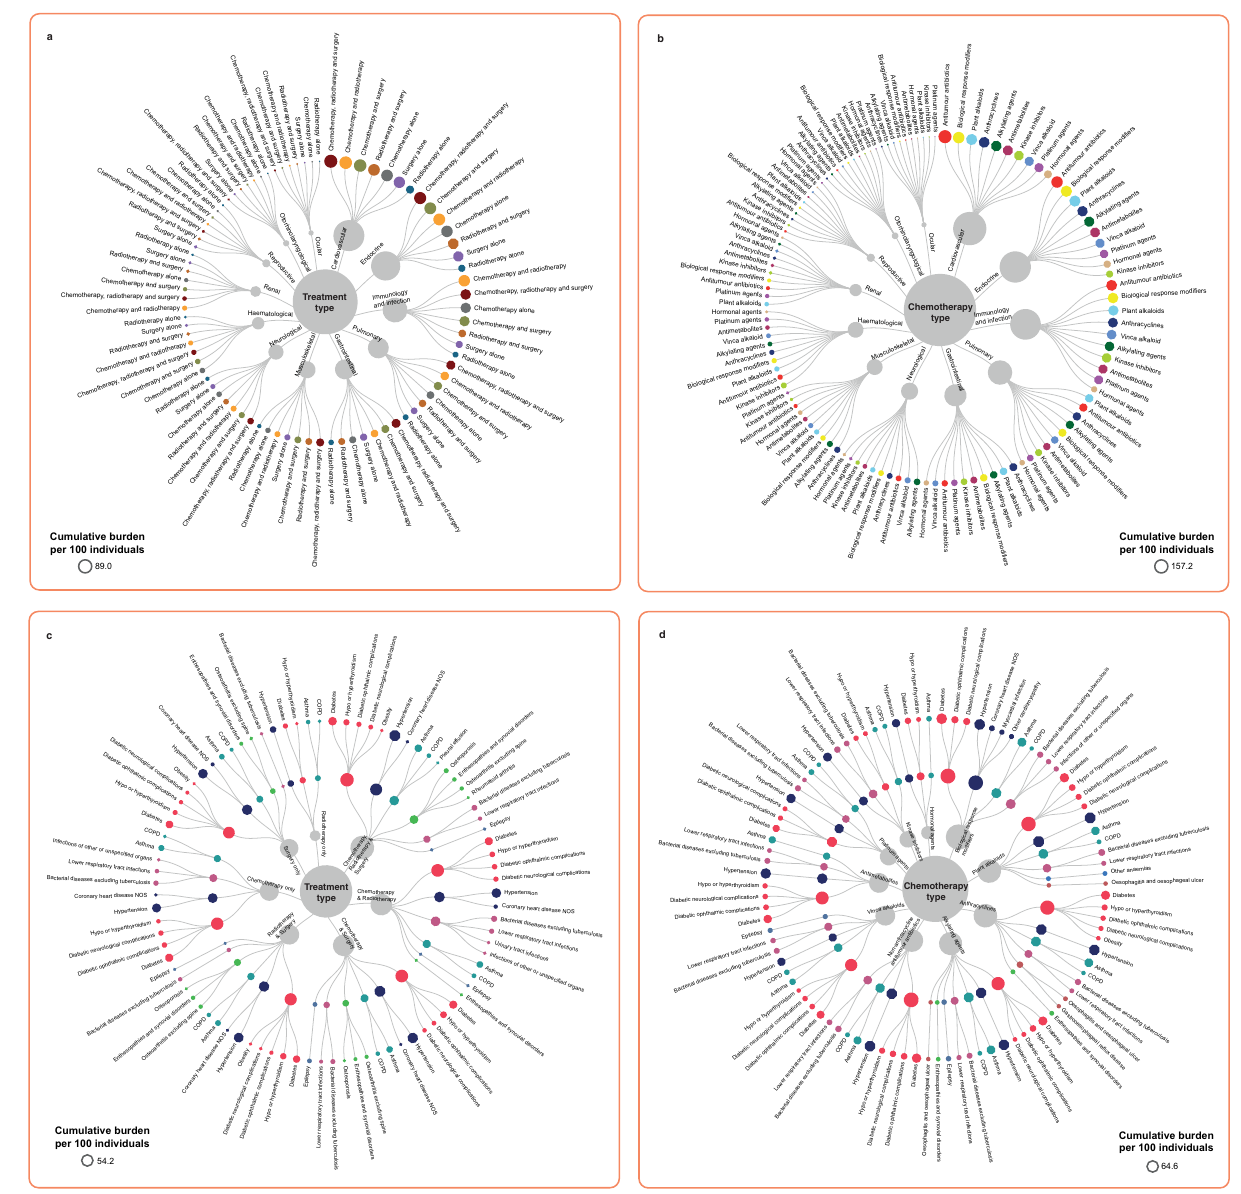
Fig. 4 |Cumulativeburdenofhealth conditionsamongcancer survivorsatage 60 by treatment type and chemotherapy agents. Cumulative burden per 100 individuals is shown. Dendrograms depict the cumulative burden of conditions where the top hierarchy is organ system followed by a treatment type or b chemotherapy type. This allows the visualisation of the burden of health condi- tions for each treatment type or chemotherapy type ranked from the highest to lowest. The area of the nodes is proportional to the burden of health conditions